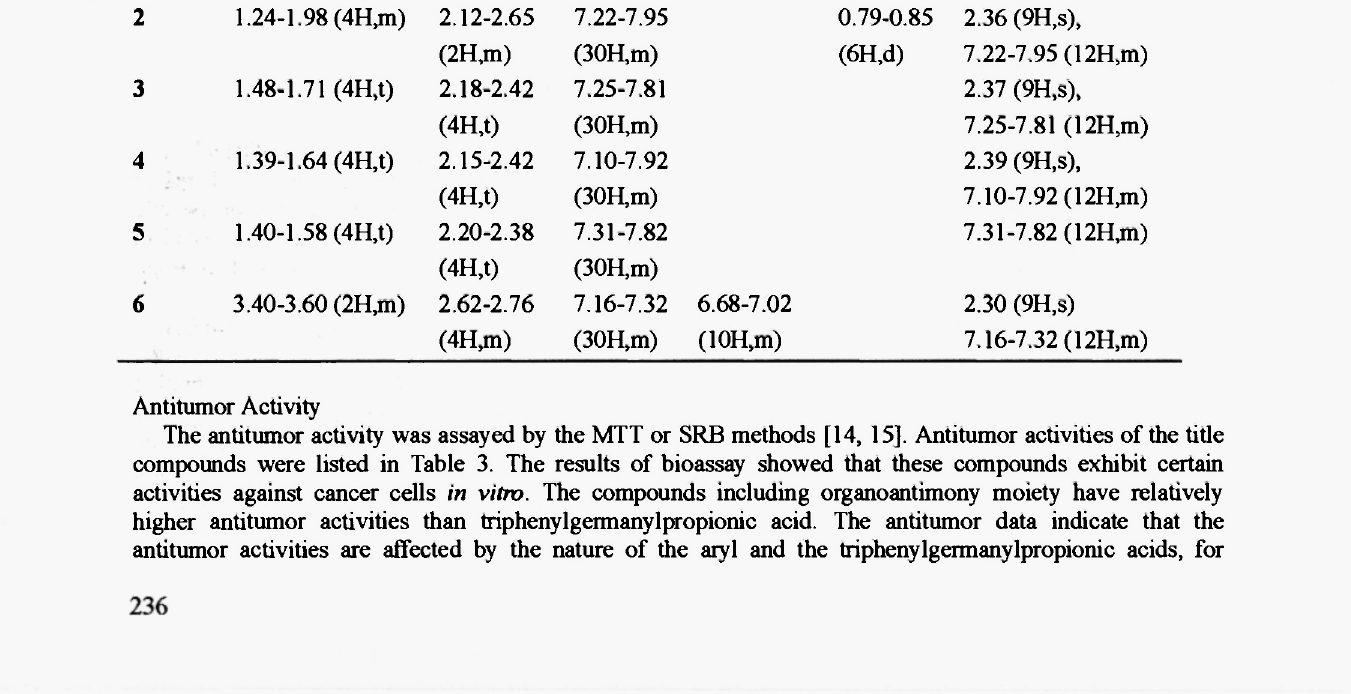
Table 2 'i i NMR data of the